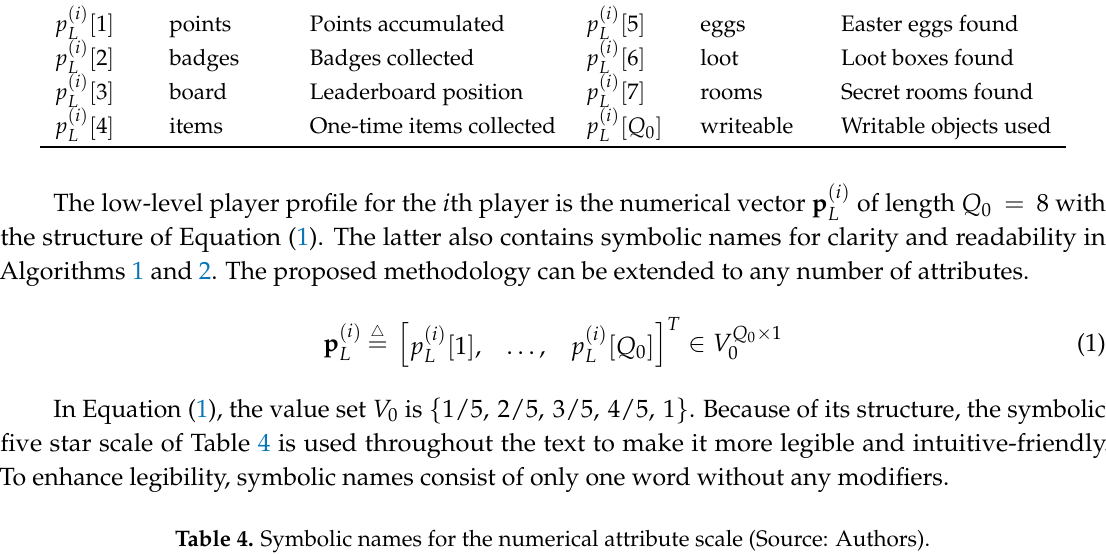
Table 3. Elements and mnemonic names for the low-level player profile (Source: [6,15,45]). Element Mnemonic Quantile Meaning Element Mnemonic Quantile Meaning points Points accumulated p badges Badges collected p board Leaderboard position p items One-time items collected p